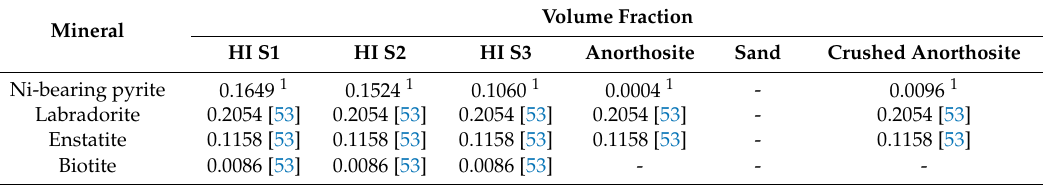
Table 3. Initial mineral volume fractions considered in the numerical model.